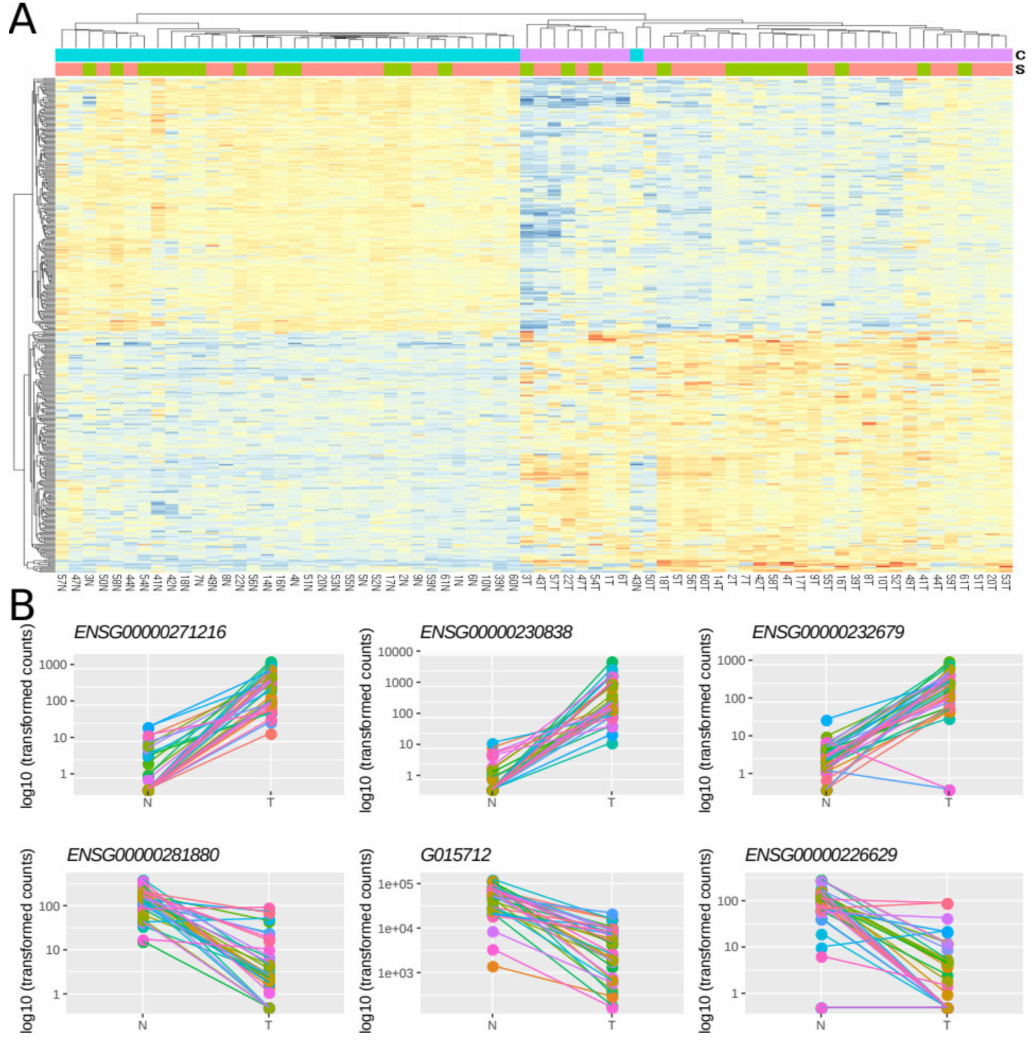
Figure 4. Di ff erentially expressed lncRNAs in FFPE CRC stage II samples. ( A ) Heatmap showing gene expression from the 379 DE lncRNAs. Color gradient ranges from low expressed (blue) to highly expressed (red). ( B ) Dot plots showing normalized count data in a logarithmic scale of normal and tumoral samples for the three top up- and down-DE lncRNAs (Table S1). Horizontal bars on top show condition (blue for normal, pink for tumoral) and sex (green for female and red for male). Each individual is represented with a di ff erent color, lines group paired samples from the same individual and T and N indicate tumoral and normal samples,